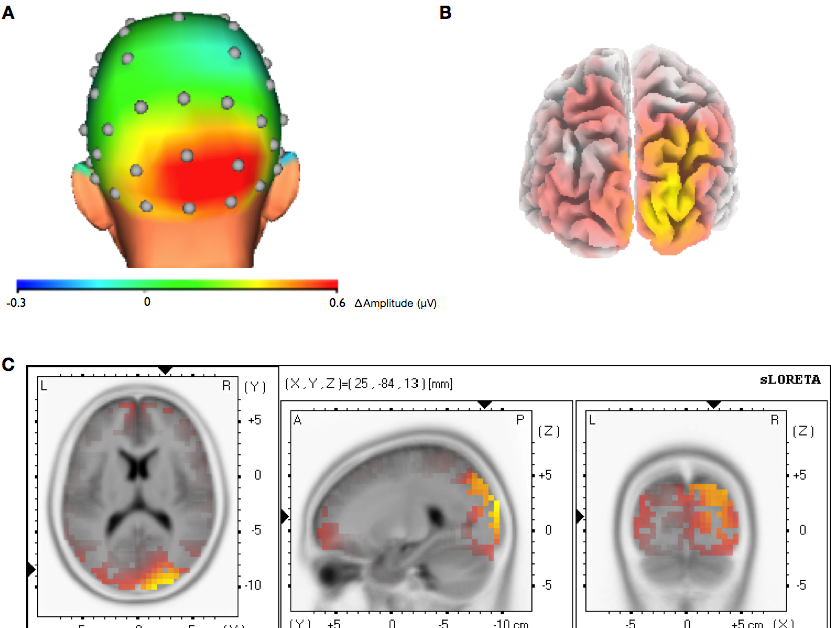
Figure 5. Topographic and spatial distribution of gamma band increase. ( A ) Topographic representation of the average change of the gamma-band activity (around 40 Hz) during the feedback period compared to the passive period within the last training session. ( B ) sLORETA analysis of the subtracted electrode potential difference of the gamma feedback sessions compared to the passive baseline. The yellow area represents the maximum estimated change of the gamma band activity to baseline. ( Back view ); ( C ) Horizontal, sagital and coronal view of the maximum change of the gamma-band